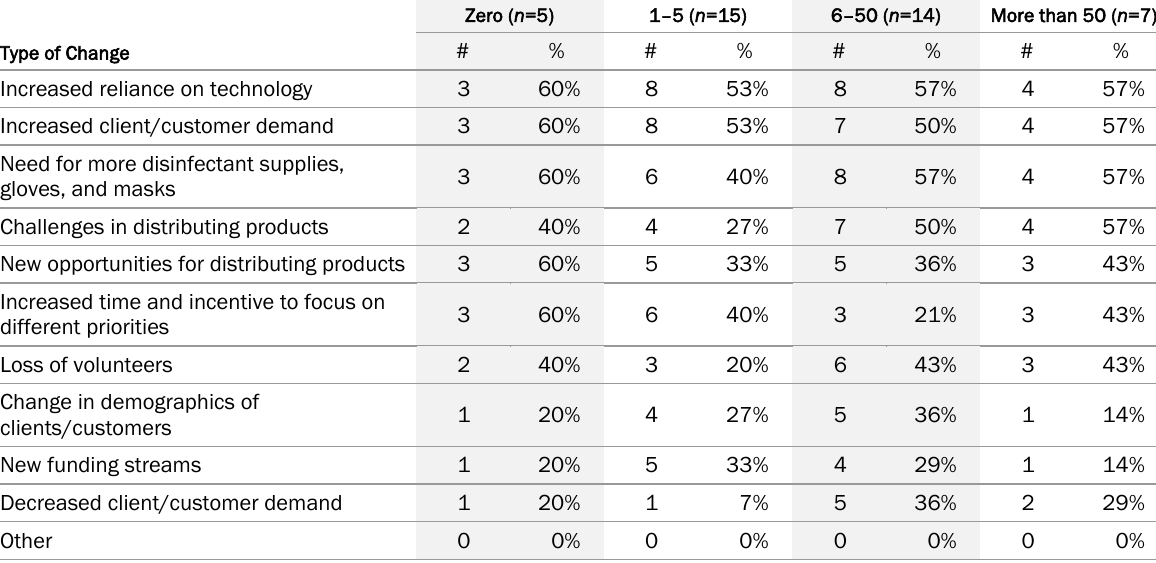
Table 3. Pandemic Impact According to Staff